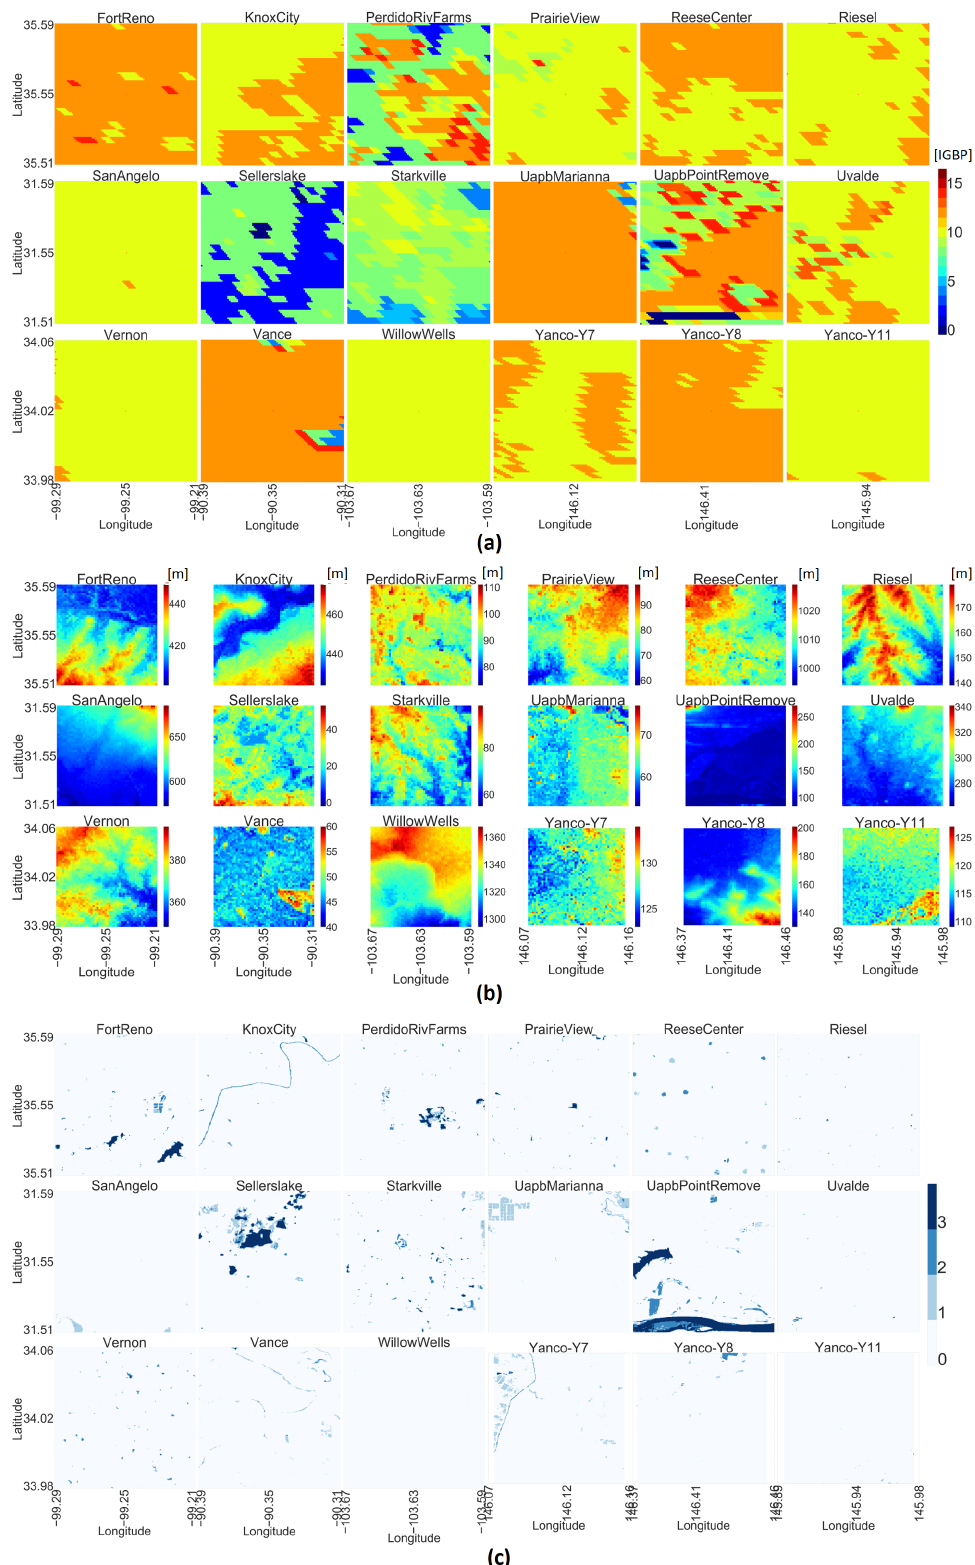
Figure 5. Ancillary data visualization for 18 ISMN sites. ( a ) IGBP land cover [IGBP]. The land cover color scale is the same as in Figure 3; ( b ) DEM [m]. DEM color scale is generated separately per each ISMN site; ( c ) inland water bodies [Pekel indices [61]]. The inland water body color scale is the same as in Figure